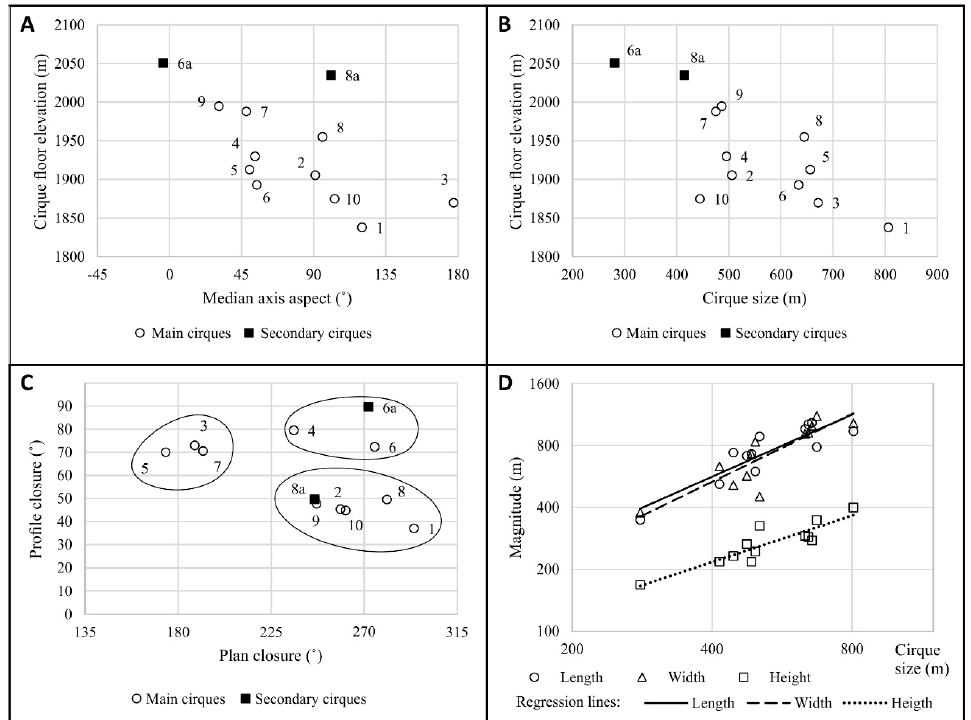
Figure 7. Graphical presentation of some morphometric characteristics of the cirques on Jablanica Mt.: Changes of cirque median axis aspect ( A ) and size ( B ) with cirque floor elevations; ( C ) Cirque plan closure vs. profile closure; ( D ) Allometric plots of cirque size ( √ L × W × H (cid:3119) ) vs. cirque length, width and height (L exponent = 1.00, r 2 = 0.79, 95% conf. int. = 0.64–1.34; W exponent = 1.09, r 2 = 0.75, 95% conf. int. = 0.65–1.54; H exponent = 0.75, r 2 = 0.80, 95% conf. int. = 0.49–1.01).